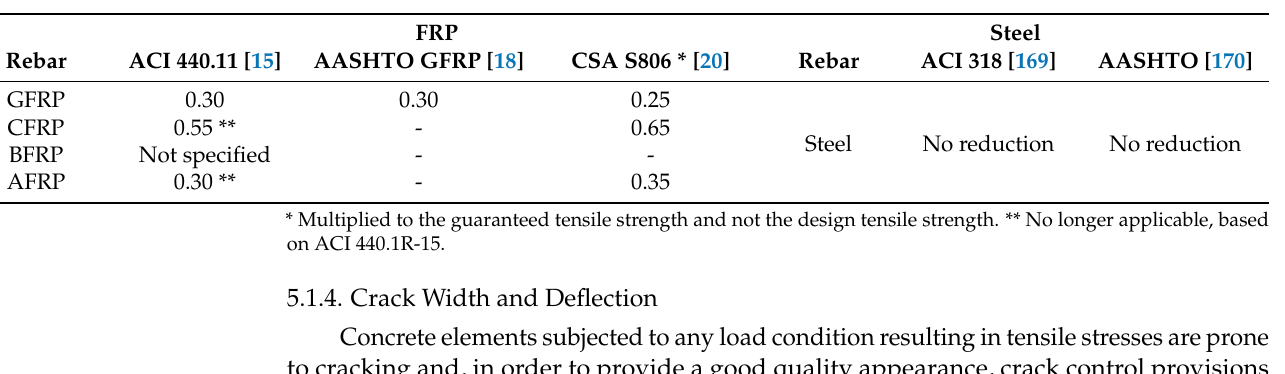
Table 7. Creep rupture reduction factor for tensile strength in different design guides and